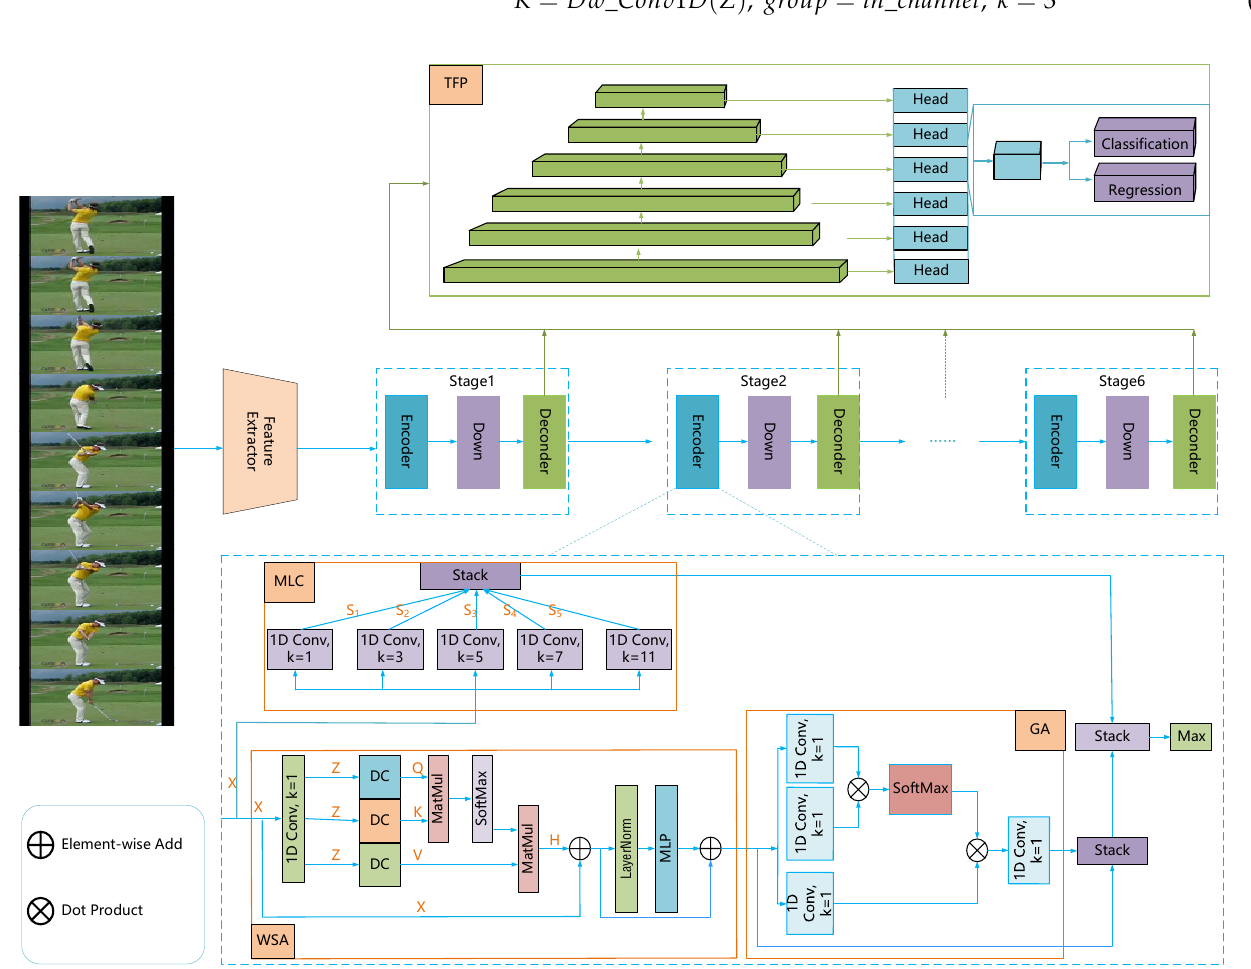
Figure 1. Overview architecture of GLFormer. We first utilize a feature extraction network to encode the raw video into clip features X ∈ R C × T , where C and T represent the channel dimension and tem- poral length, respectively. Our model consists of four unique designs: a multi-scale local convolution (MLC) module for capturing the multi-scale context information, a window self-attention (WSA) module for exploring the relationship between features within the window range, a global attention (GA) module for establishing long-range dependencies across the full sequence, and a temporal feature pyramid module compatible with action instances of various durations. Finally, the model outputs the predicted action category and boundary regression results to produce